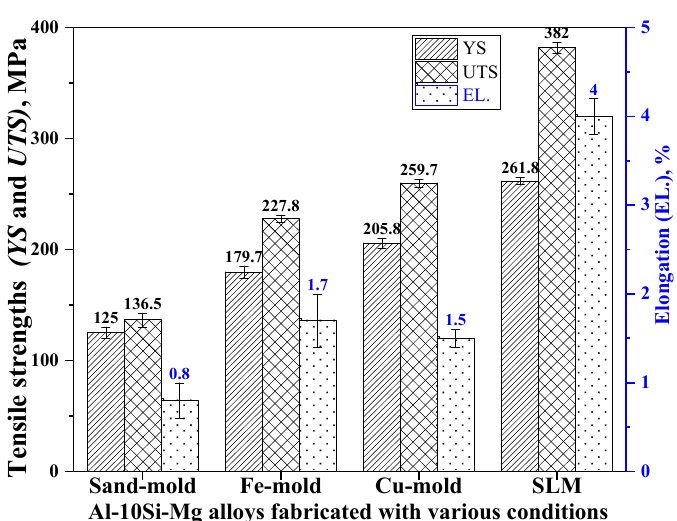
Figure 10. Tensile properties of Al-10Si-0.5Mg alloys prepared under different conditions.